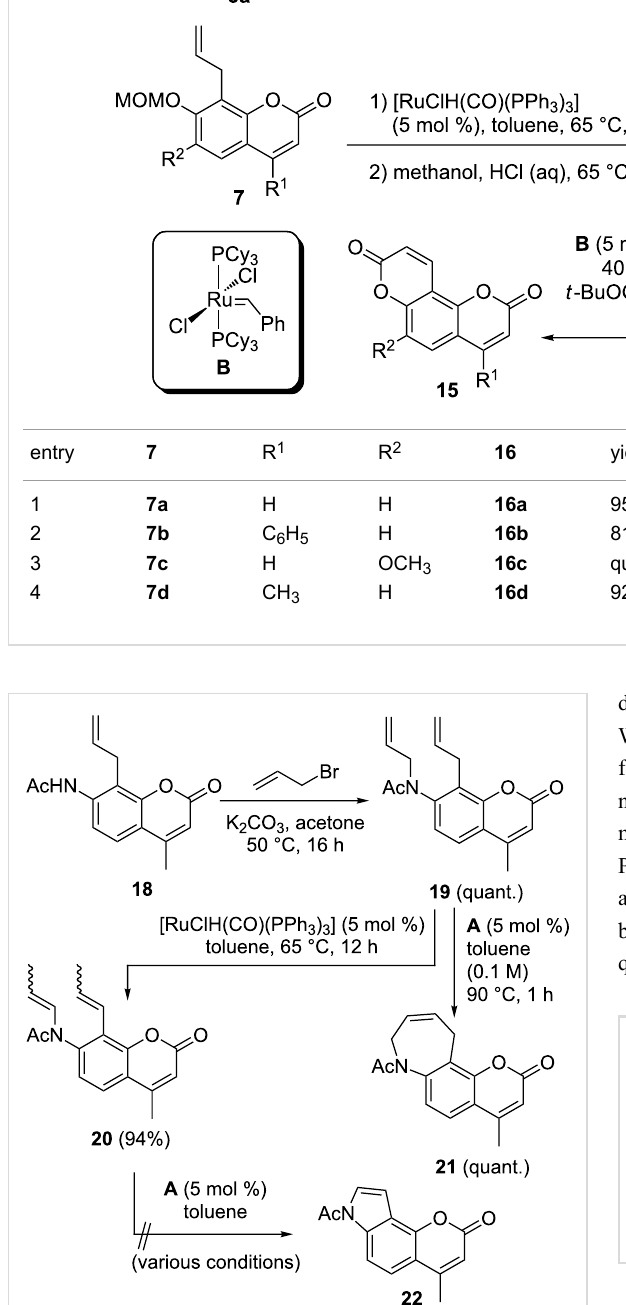
Scheme 3: Synthesis of aza-annellated coumarin 21 and attempted synthesis of indole 22